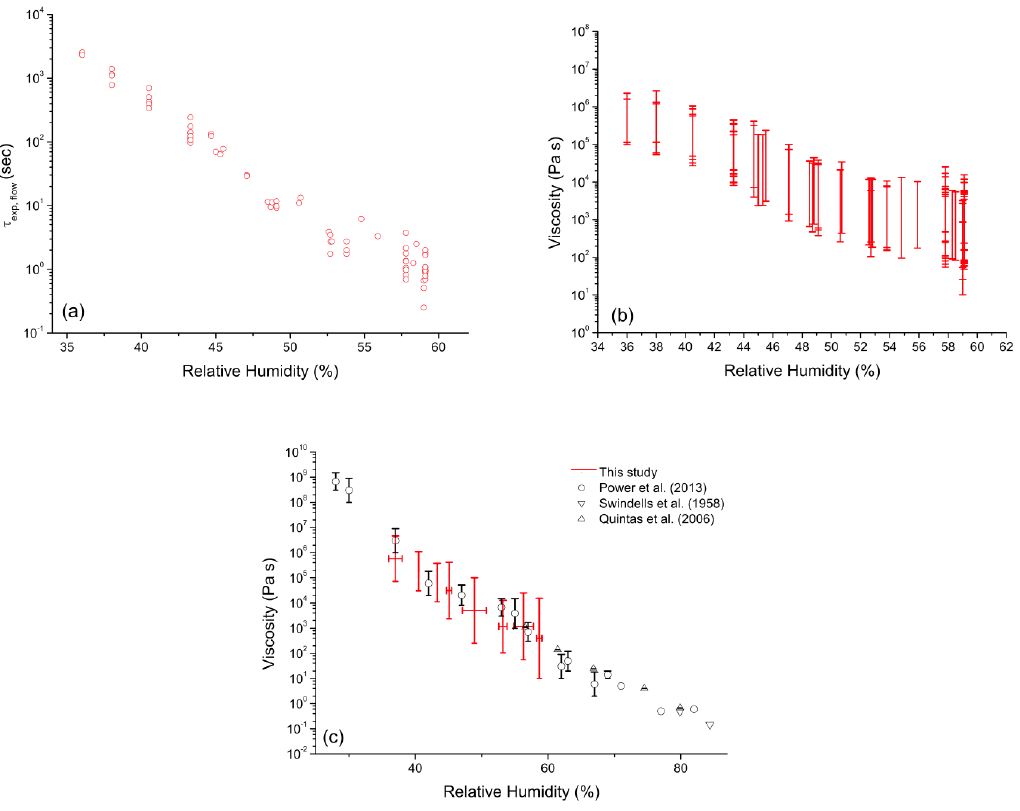
Figure 4. (a) τ exp, flow as a function of RH for individual sucrose–water particles. (b) Calculated viscosities for the individual sucrose–water particles in (a) , where red bars represent the calculated lower and upper limits of viscosity. (c) Lower and upper limits of viscosity for the particles shown in (b) , grouped by RH. The error bars on the x axis represent the range of RHs at which particles in the group were poked. Lower and upper limits of viscosity were determined for each particle via simulation, with the bottom of a bar on the y axis representing the lowest lower limit of viscosity for any of the particles in the group, and the top of the bar representing the highest upper limit of viscosity for any of the particles in the group. Literature values (Swindells et al., 1958; Quintas et al., 2006; Power et al., 2013) are provided for comparison, with error bars representing 1 σ for Power et al. and 95% confidence intervals for Quintas et al. Table 2. Experimental parameters used when simulating flow with COMSOL for experiments using polybutene